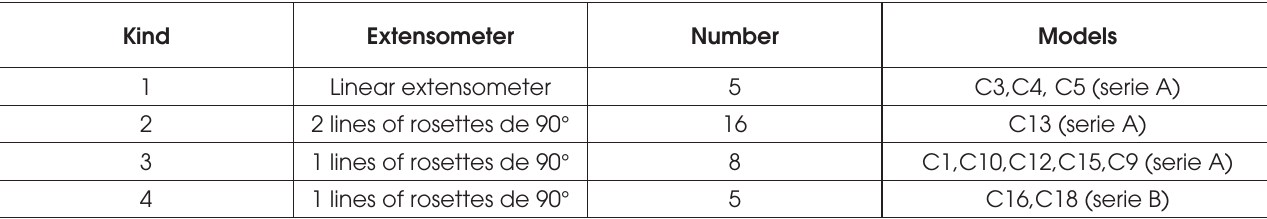
Distribution of models for each kind of extensometer adopted Kind